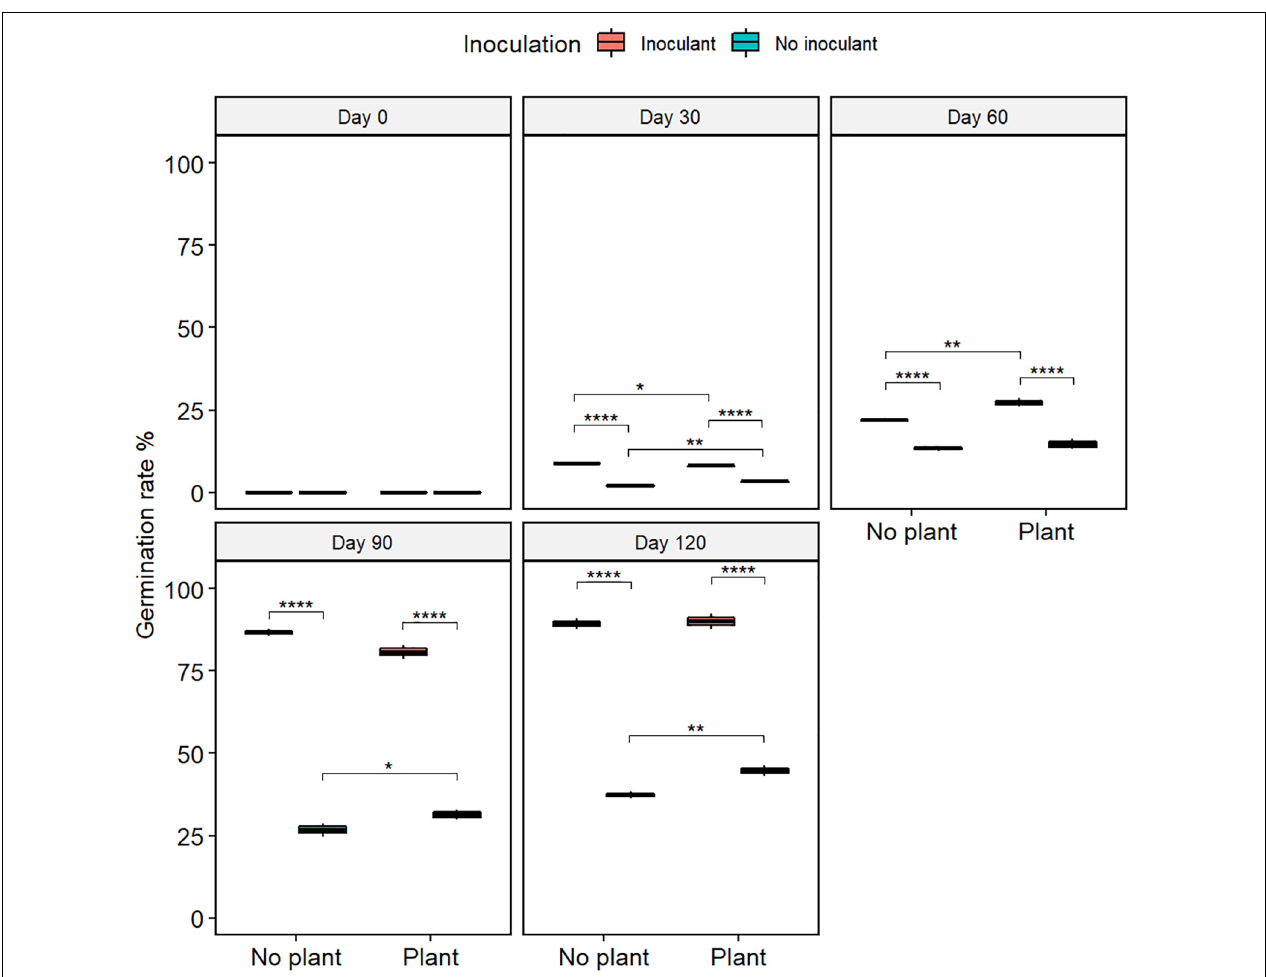
FIGURE 2 | The germination rate of red clover seeds in waste drill cuttings (WDCs). WDCs were incubated in a greenhouse for 120 days with and without black locust ( Robinia pseudoacacia ) plant and with or without bacterial and fungal consortium inoculant. Statistically significant differences are indicated with